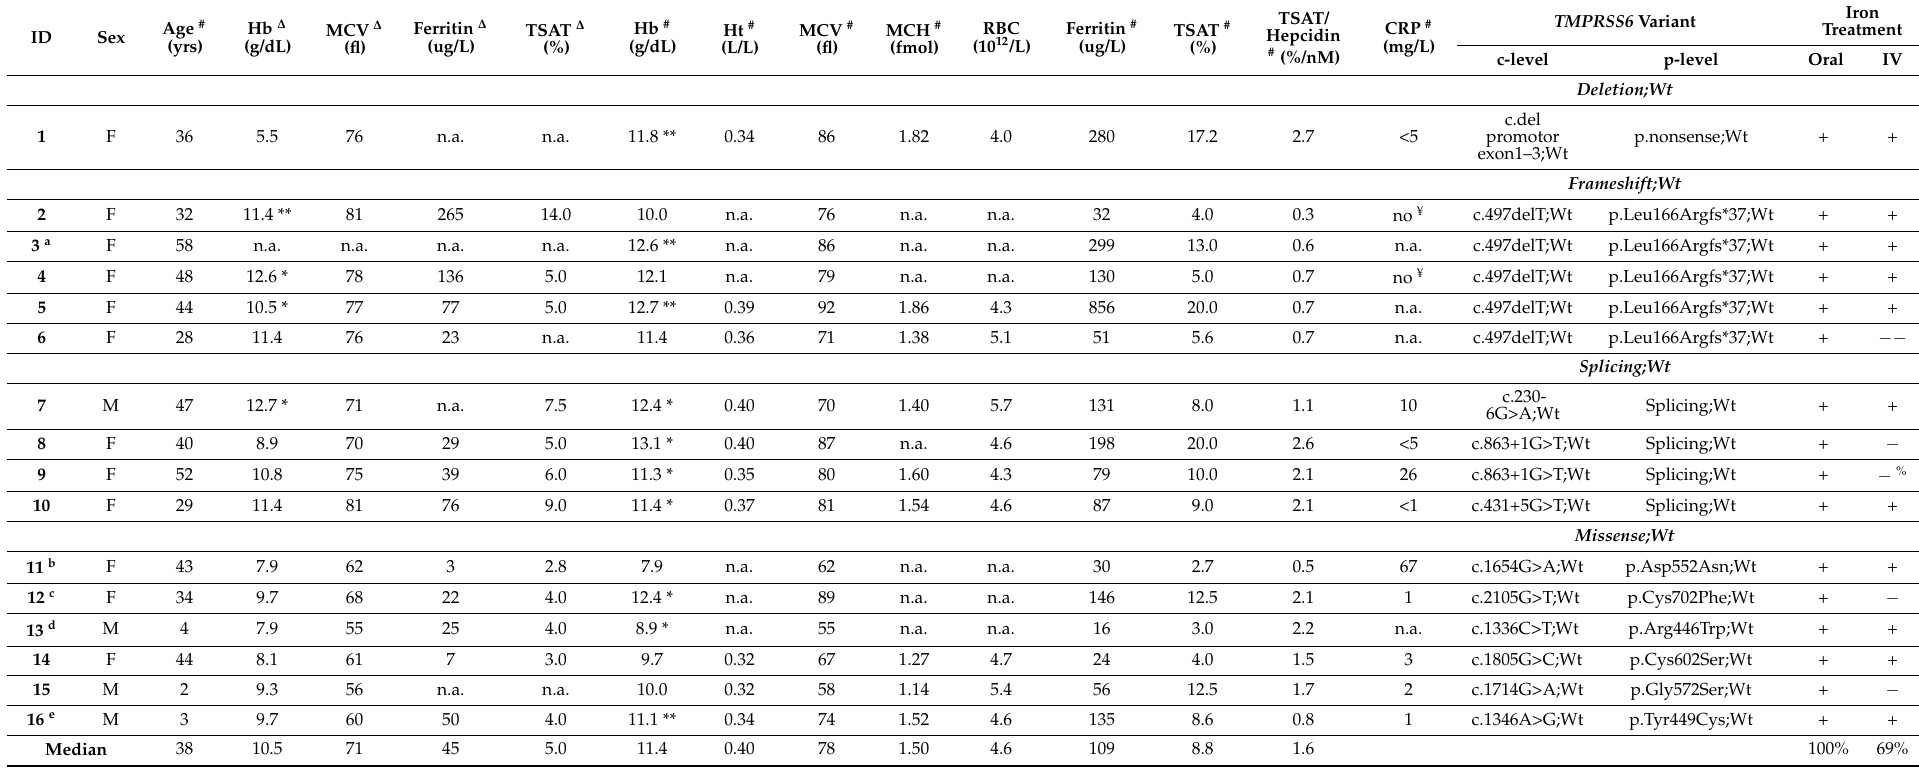
Table 1. Characteristics of patients with a monoallelic TMPRSS6 variant and IRIDA